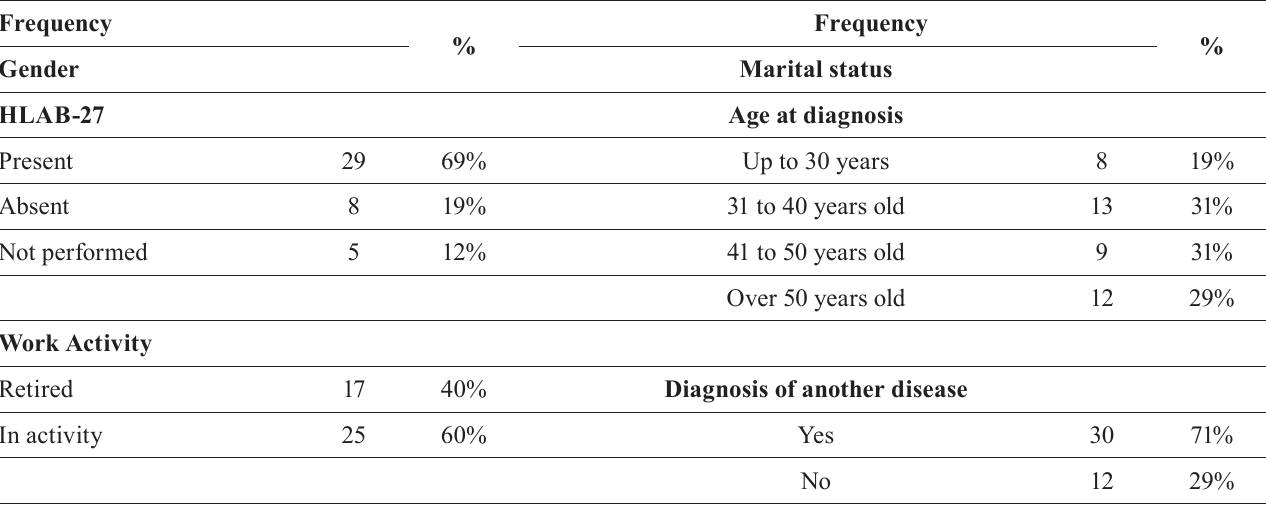
TABLE I – P rofile of participants with AS treated at the Pharmacy of the 9 th Regional Health of the State of Paraná